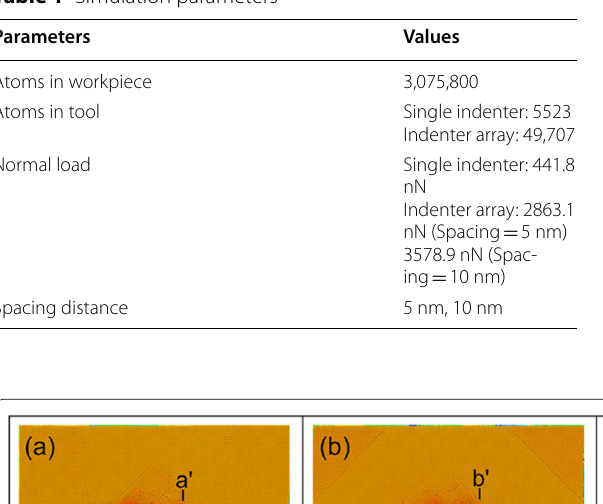
Fig. 2 Indentation morphology a indenter with feed feed 10 =